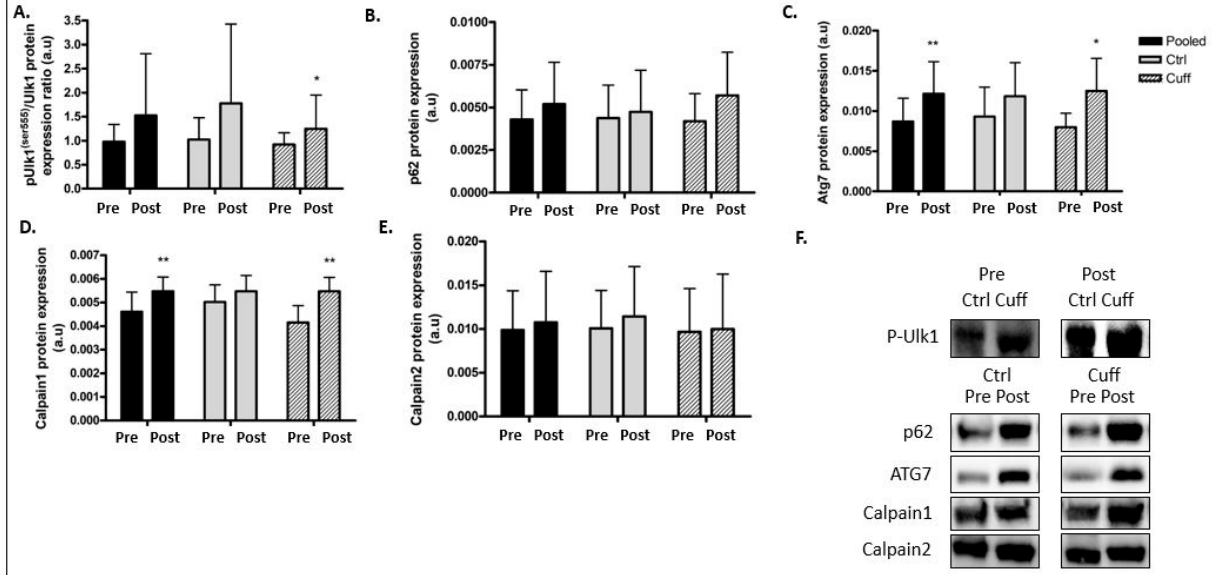
Figure 6. Effect of 5 days of DI on autophagic and calpain markers. Autophagy markers activation access by western blot analysis. ( A ) pUlk1 ser757 /Ulk1 protein ratio. ( B ) p62 protein expression. ( C ) ATG7 protein expression. ( D ) Calpain1 protein expression measurement. ( E ) Calpain2 protein expression measurement ( F ) Western blot picture analyzed by groups. * different from pre value in the same group. * p < 0.05; ** p <